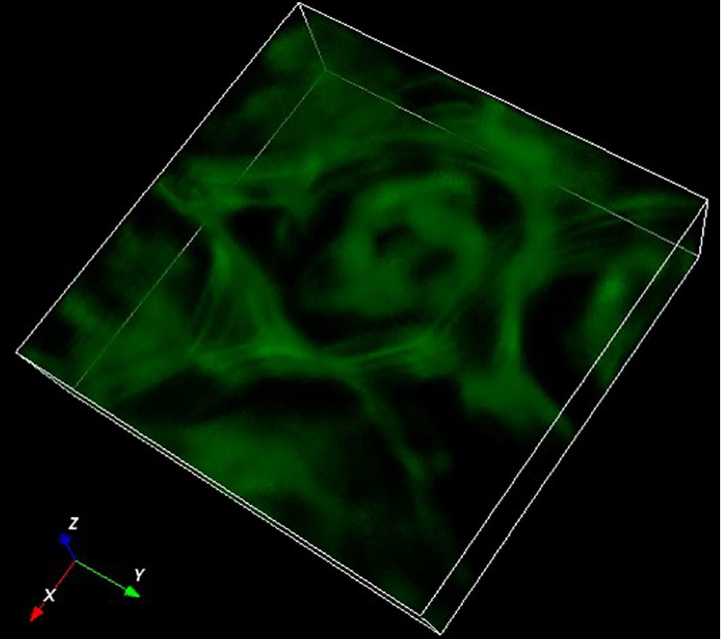
Fig 6. An isometric view of the constructed mouse kidney specimen based on the HiLo